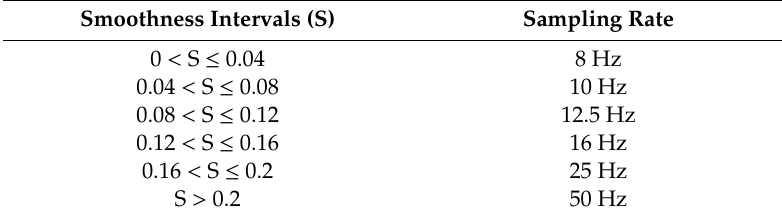
Table 2. Change of sampling rate.